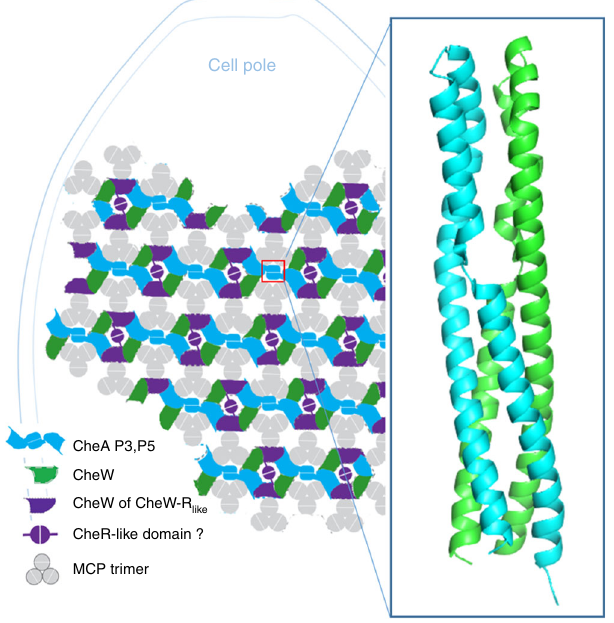
Fig. 7 The arrangement of chemotaxis proteins in Td . The linear organization of CheA produces “ strands ” of CheA:CheW rings that are perpendicular to the cell axis and are linked by an atypical P3 domain. While the placement of CheA is discernible in the sub-tomogram averages, the positioning of the two CheW domains in the rings is unclear but is illustrated in this model for simplicity.